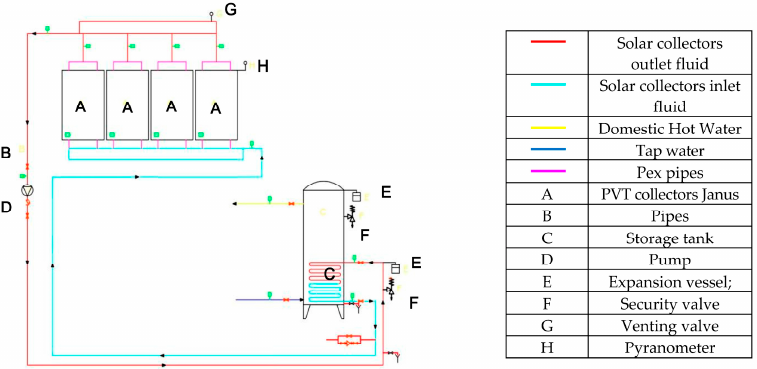
Figure 5. Experimental set ‐ up layout.